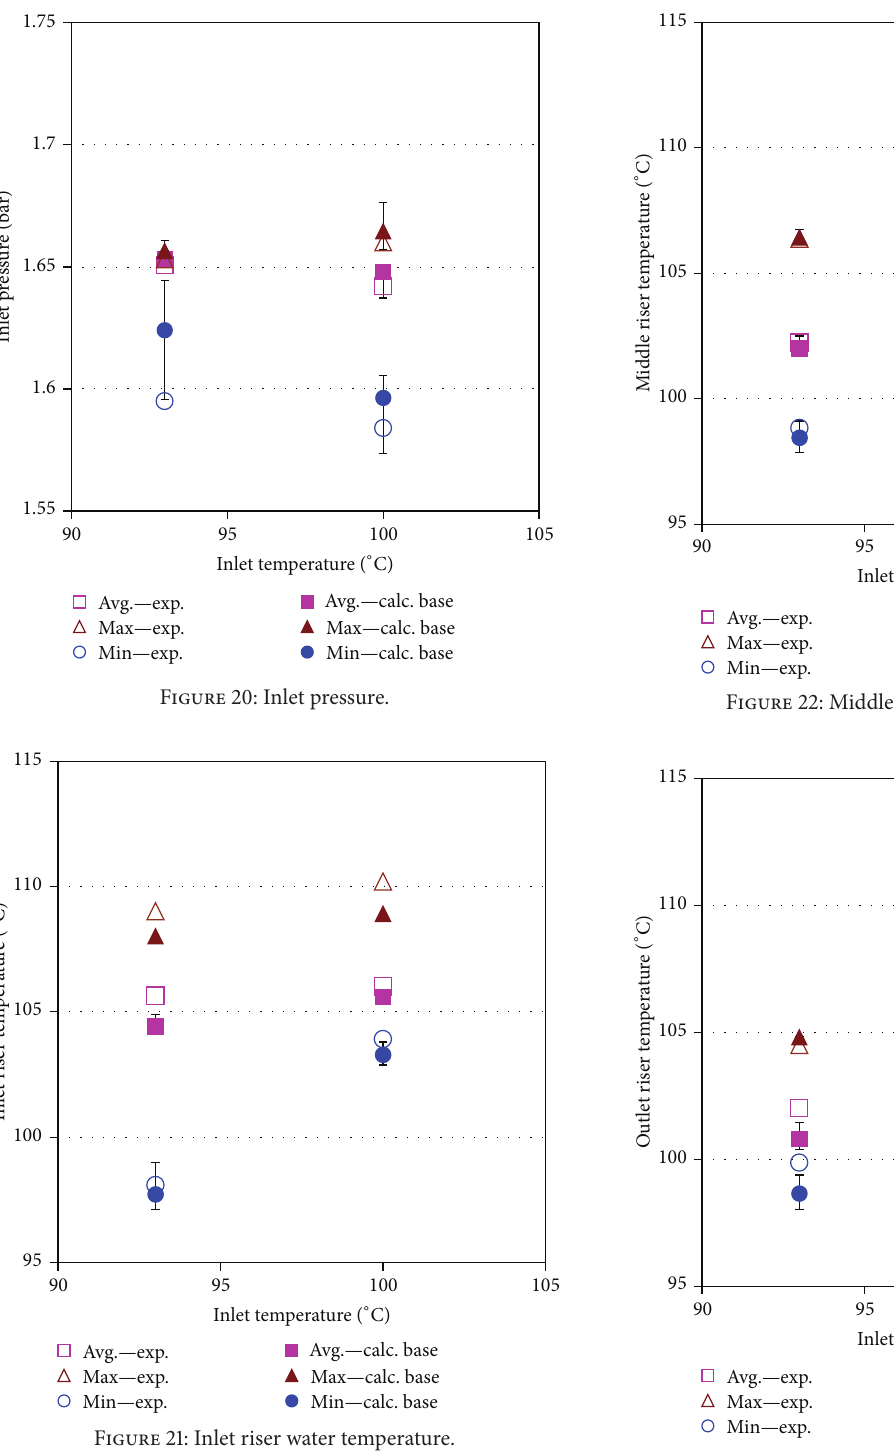
Figure 23: Outlet riser water